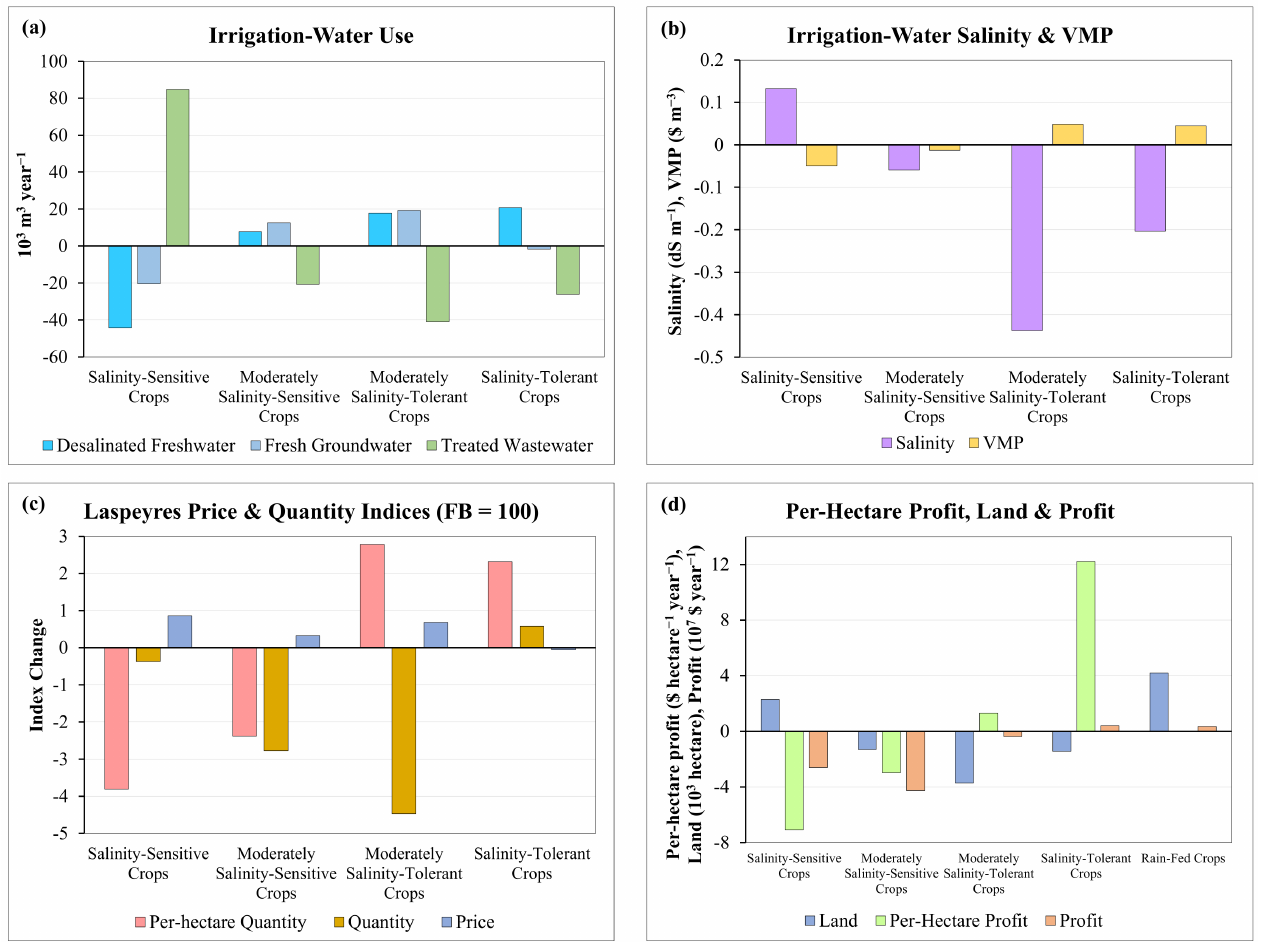
Figure 6. Differences between the RB and FB scenarios (RB minus FB) with respect to ( a ) irrigation water use, ( b ) salinity and VMP of irrigation water, ( c ) changes in Laspeyres quantity and price indices, and ( d ) land allocation, per hectare profit, and total profit—all reported for the groups of crops classified based on their salinity